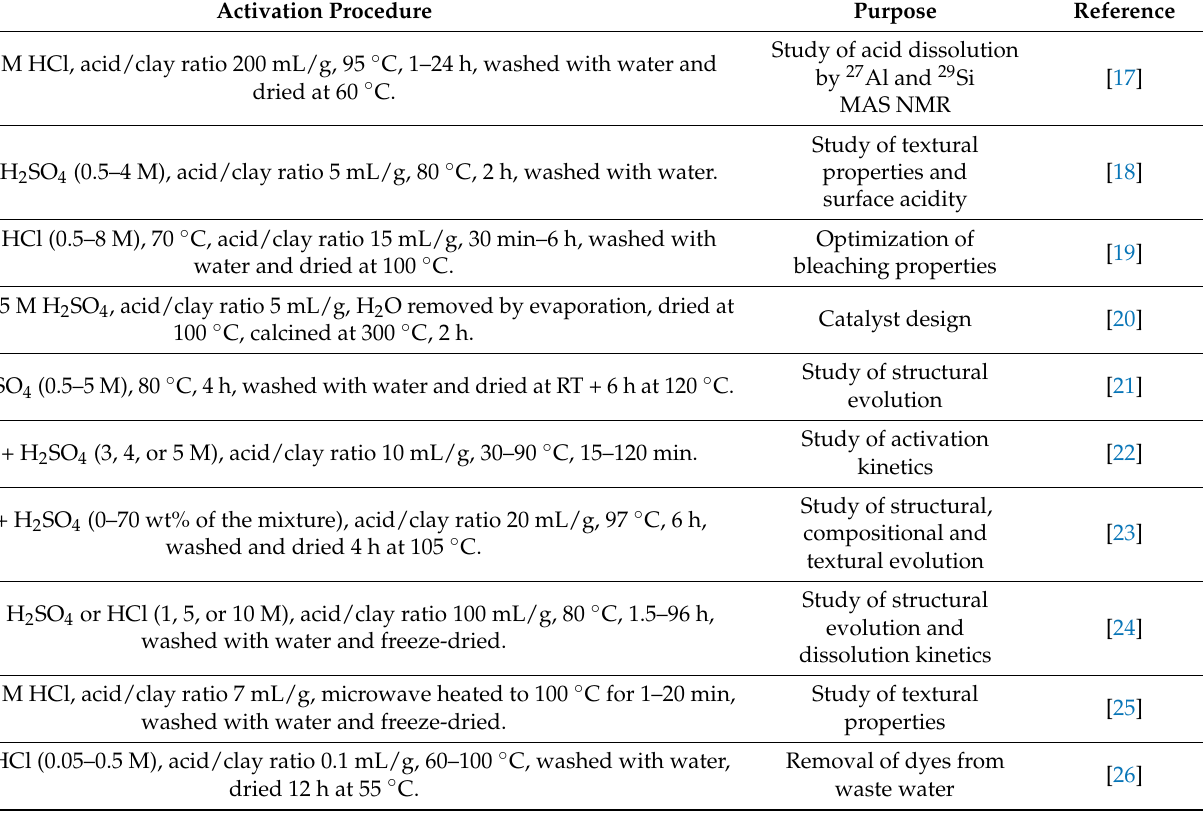
Table 1. Examples of acid-activation procedures described in the open literature (Bent—bentonite,